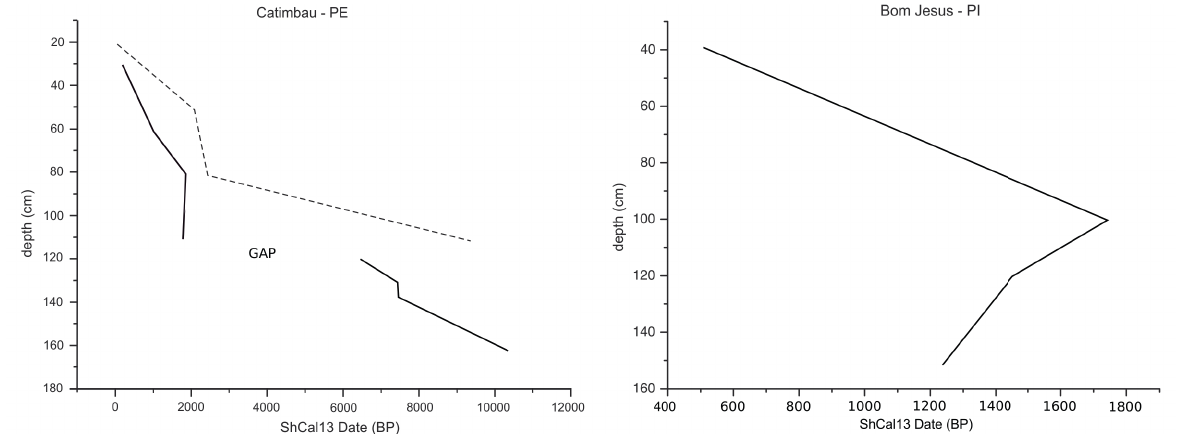
Figure 2 - Oxcal 4.3 (Ramsey 2008) calibrated age-depth models for the Vale do Catimbau and Bom Jesus peat sequences. The Catimbau data (this study) is given as a continuous line whereas the dotted line represents the age-depth models applied to Nascimento’s data